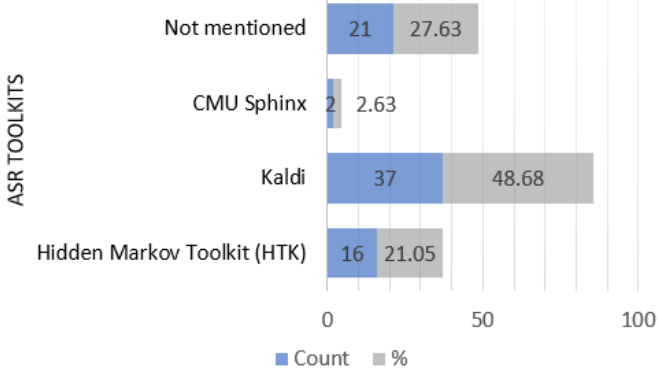
Figure 7. Toolkits used for speech recognition.